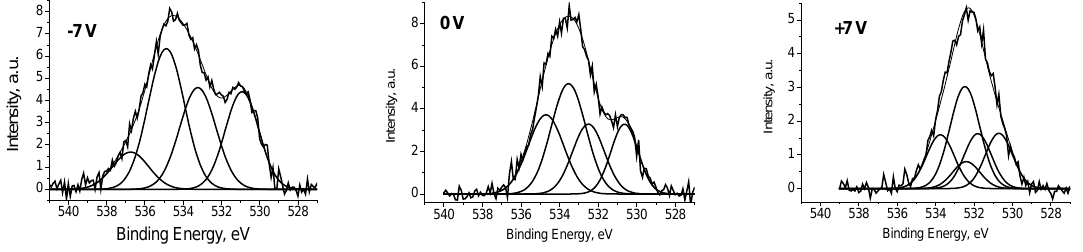
Figure 8. Fitting the O 1s photoelectron spectrum of Ag black measured at U b = − 7, 0 and 7 V.